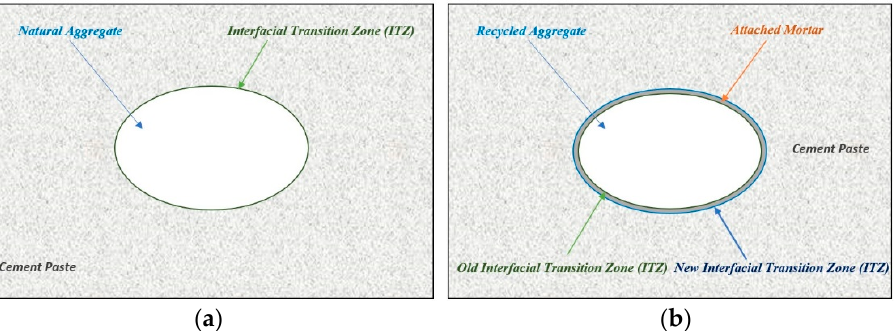
Figure 1. ( a ): Interfacial Transition Zone between NA and cement paste; and ( b ) Interfacial Transition Zone in the case of RA. Zone in the case of